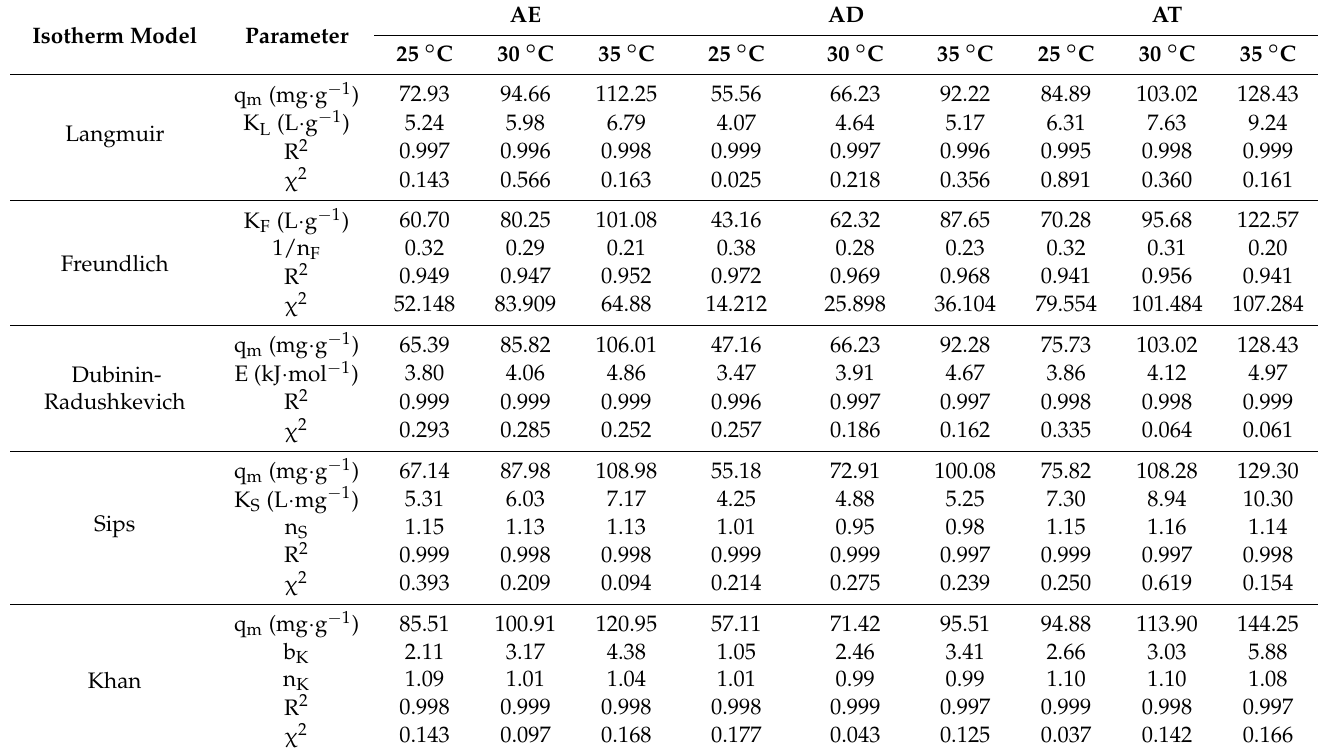
Table 8. Two- and three-parameter isotherm values for adsorption of metronidazole onto AE, AD and AT